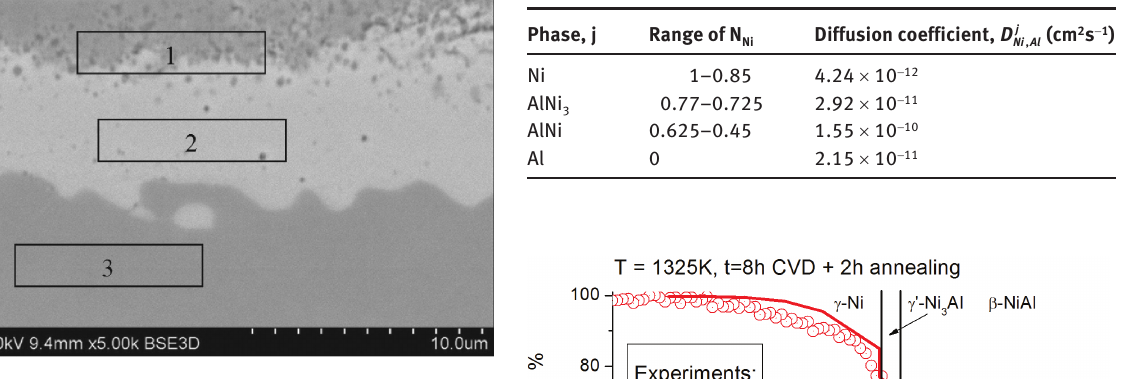
Fig. 6: Microstructure of the coating deposited by EB-PVD method after diffusion treatment after 4 h at 1325 K.